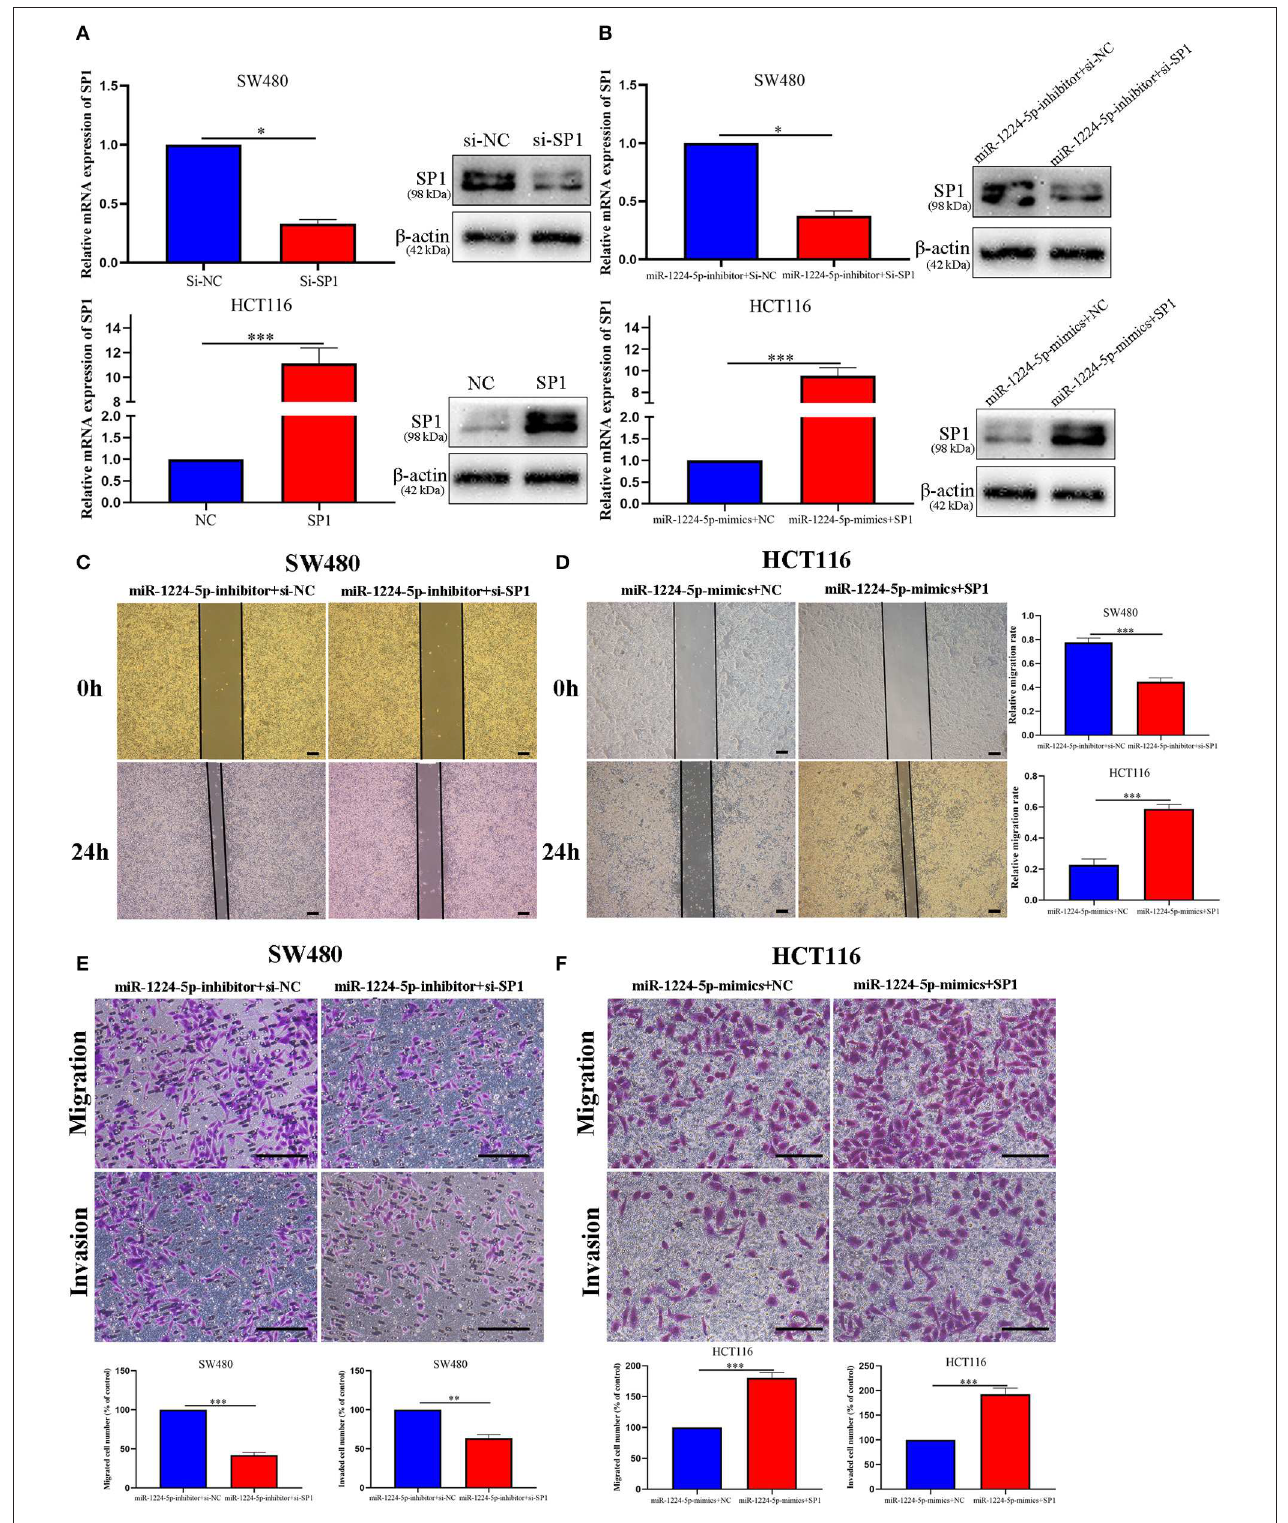
FIGURE 6 | MiR-1224-5p inhibits migration and invasion by targeting SP1. (A) Expression of SP1 mRNA and protein was verified in transfected CRC cell lines by qRT-PCR and western blot. (B) Expression of SP1 was confirmed by qRT-PCR and western blot in co-transfected CRC cell lines. (C,E) Wound healing assay and Transwell assays confirmed that SP1 knockdown abrogated the effects of miR-1224-5p loss on migration and invasion of SW480 cells, scale bars: 300 µ m (C) and 100 µ m (E) . (D,F) SP1 restoration promoted migration and invasion of miR-1224-5p-overexpressing of HCT116 cells, scale bars: 300 µ m (D) and 50 µ m (F). Data represent the mean ± SD from three independent experiments. Student’s t -test was used to determine statistical significance: * p < 0.05, ** p < 0.01, and *** p < 0.001.